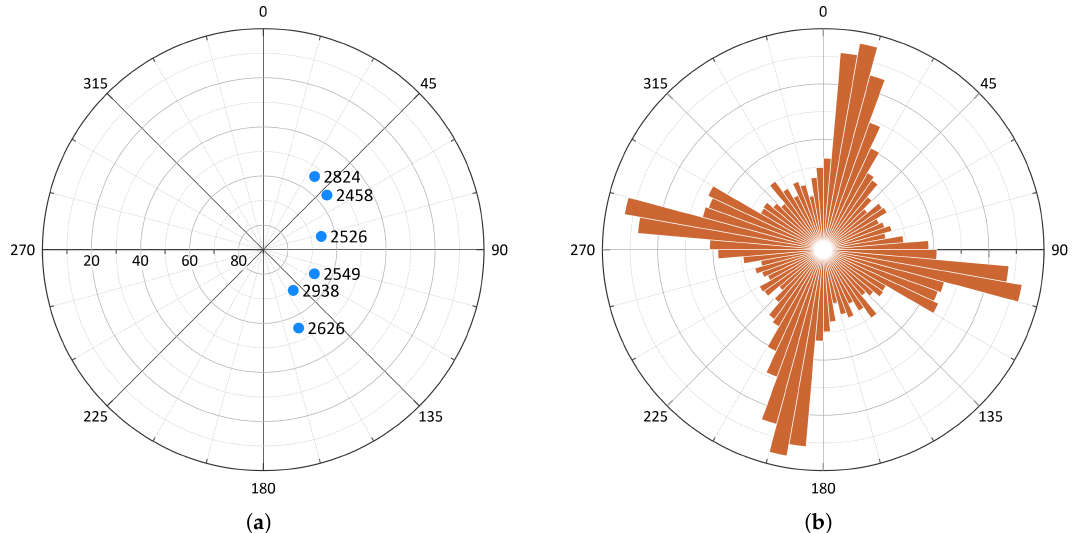
Figure 2. ( a ) sky plot with satellite azimuth and elevation angles at the time of acquisition; ( b ) polar histogram of the city centre road azimuths derived by the technical